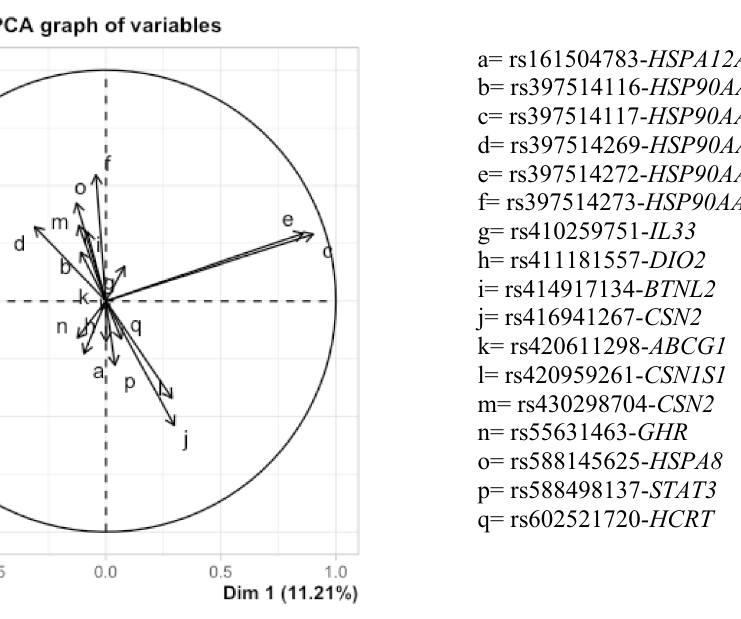
Figure 2. Loading biplot of principal component analysis of the 17 SNPs for 17 sheep